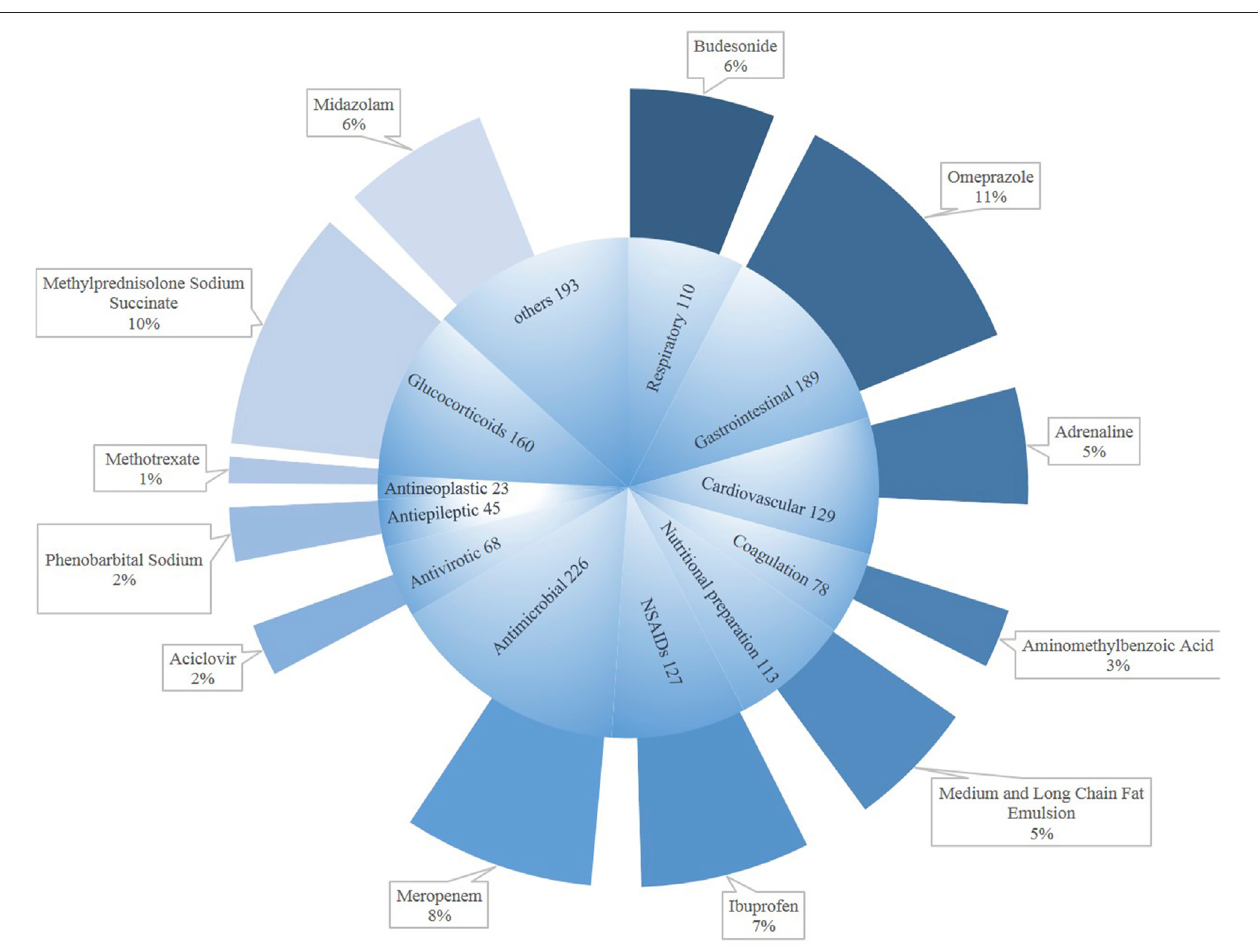
FIGURE 3 | Drug categories for DILI in